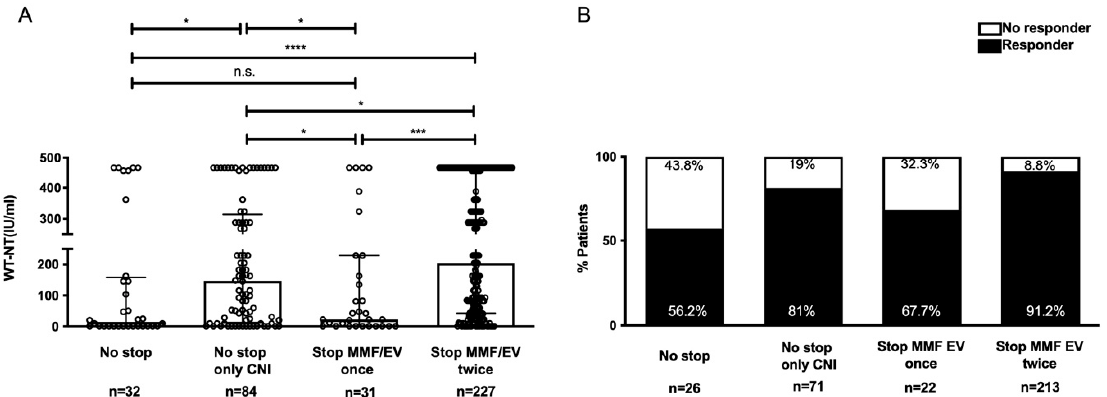
Figure 3. Comparison of the humoral responses (SARS-CoV-2 NT 50 antibodies) and the proportion of responders (SARS-CoV-2 NT 50 ≥ 9.62 IU/mL) according to immunosuppression adjustment. ( A ) SARS-CoV-2 NT 50 antibodies. Data are expressed as median and interquartile range. n.s., not significant, * p < 0.05, *** p < 0.001, **** p < 0.0001 (Mann–Whitney U-test). ( B ) Percentage of responders vs. nonresponders. Abbreviations: CNI, calcineurin inhibitors; MMF, mycophenolate